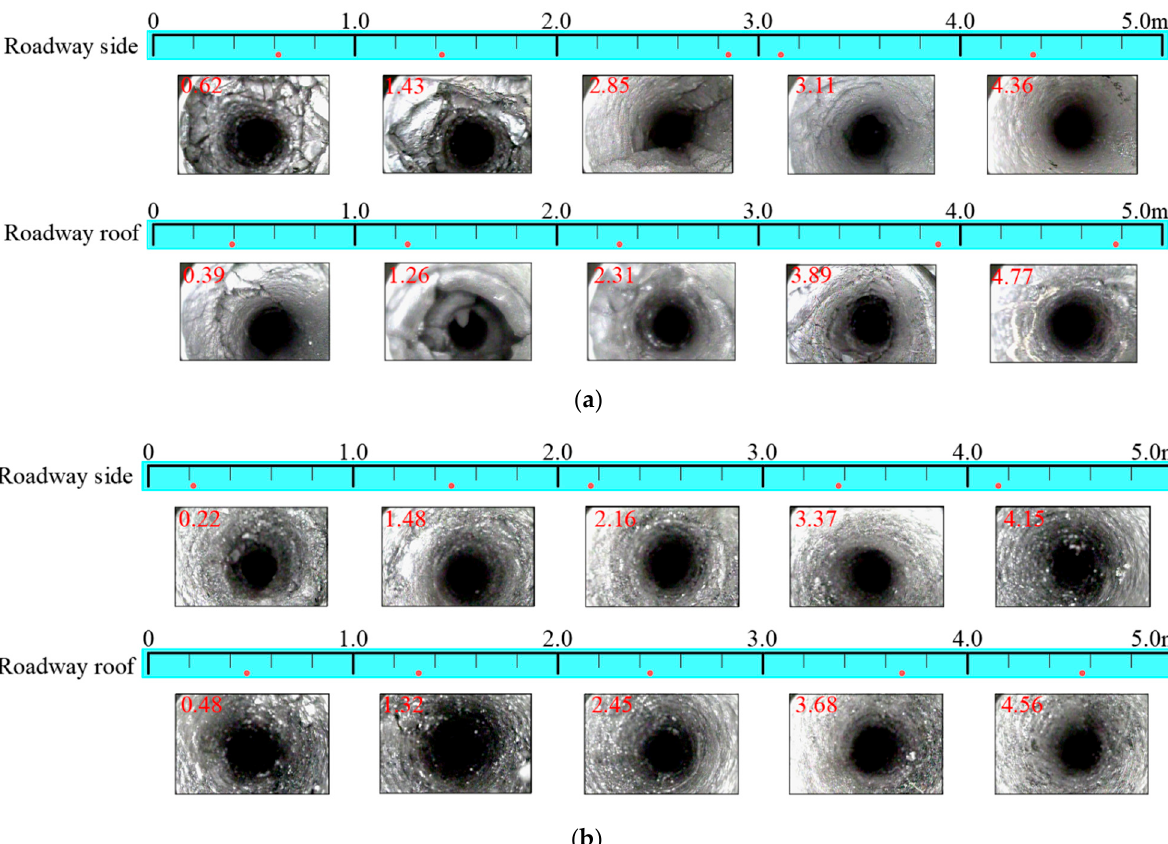
Figure 13. Fracture characteristics of the surrounding rock before and after optimization of support parameters. ( a ) Before the optimization of the support parameters; ( b ) after the optimization of the support parameters.